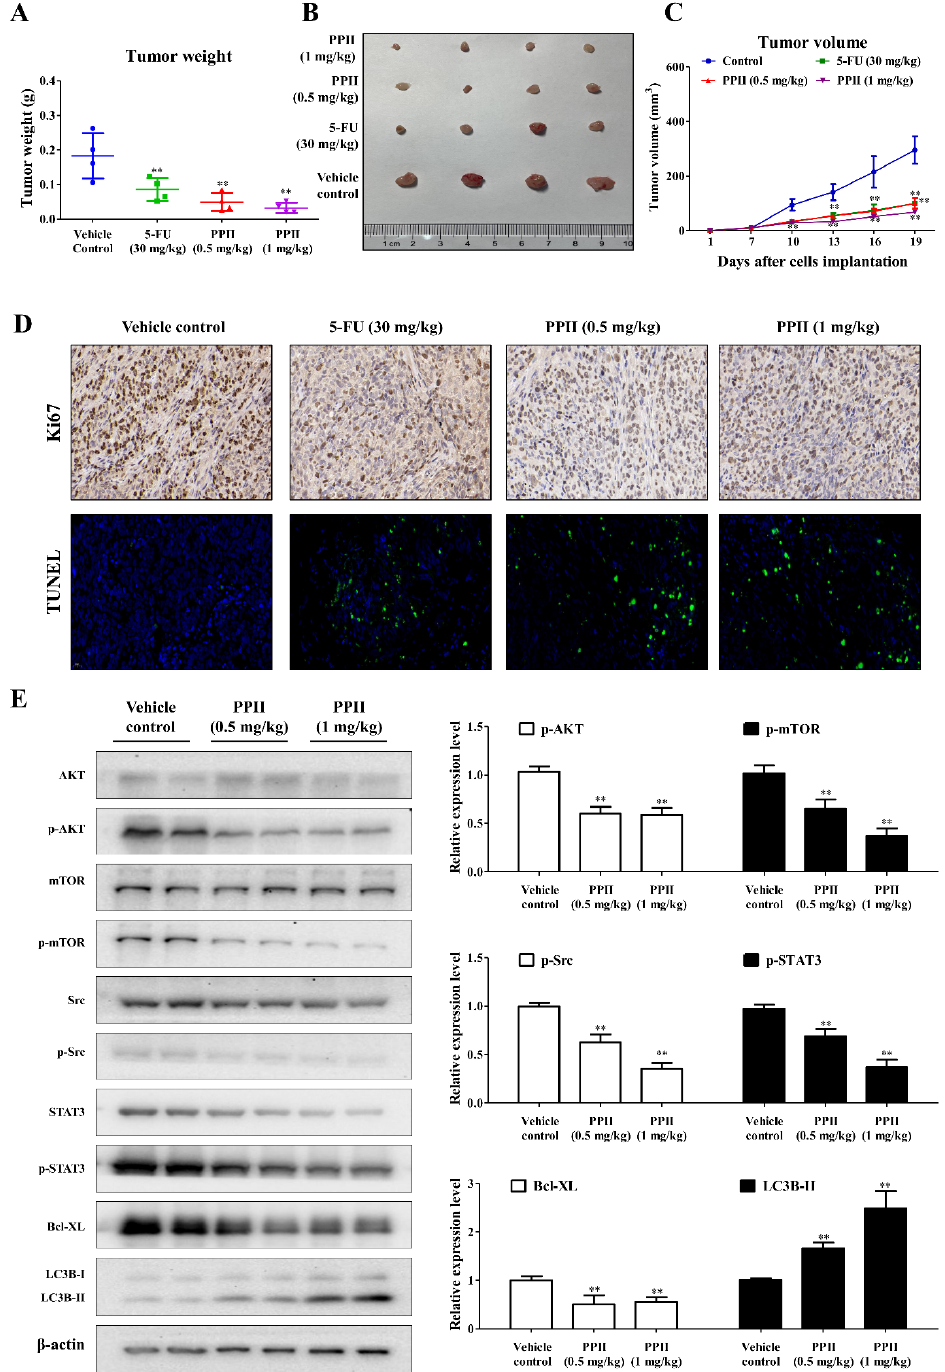
Figure 7. PPII inhibits HCT116 tumor growth in mice. Mice were i.p. administered with the vehicle control (PBS solution containing 5% PEG400 and 5% Tween80), PPII (0.5 mg/kg, once every three